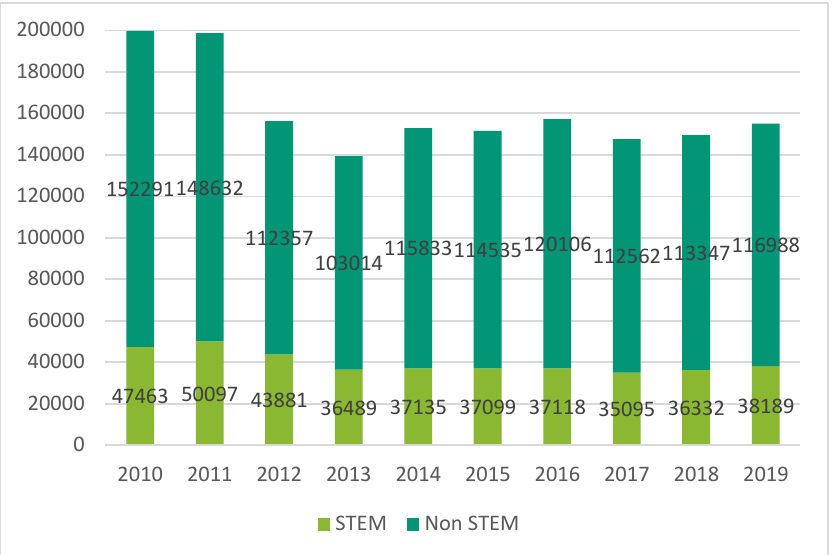
Fig. 2. Application numbers for STEM and Non-STEM